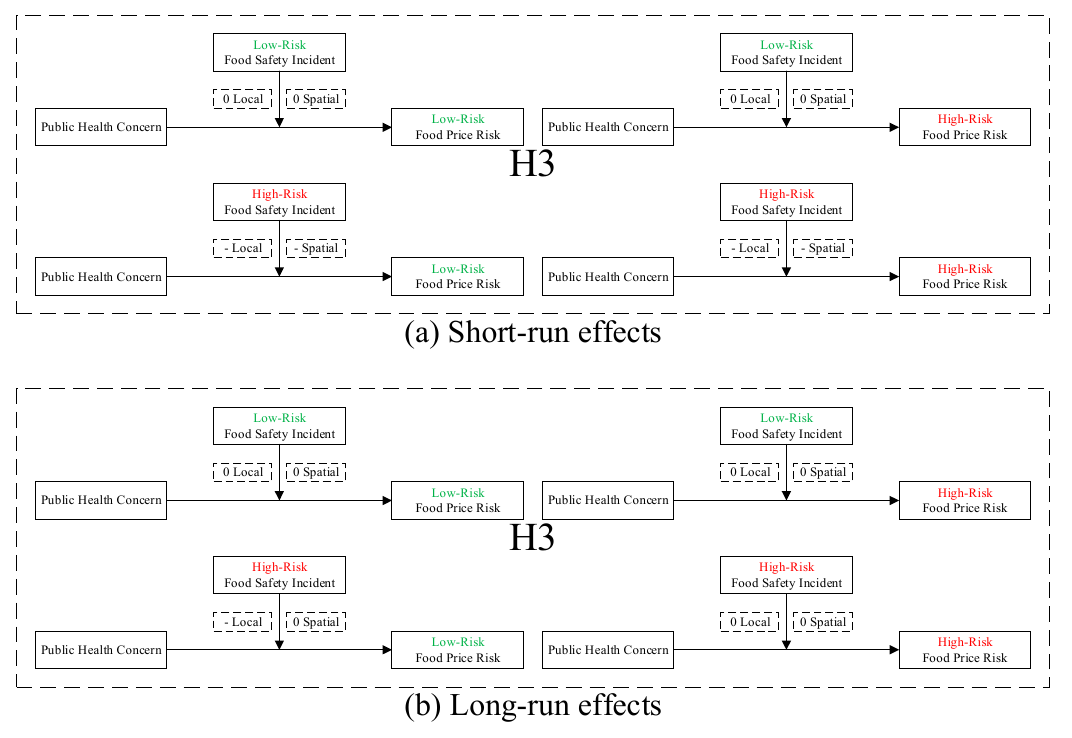
Figure 7. Test results for hypothesis H3. The symbols “0” and “-” show “insignificant” and “negative” moderation, respectively. Source: Originally developed by the authors.